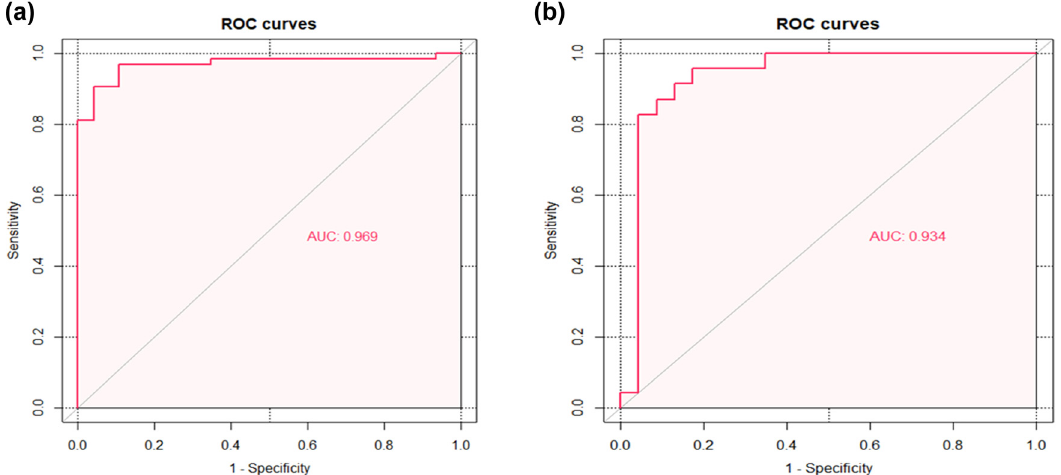
Figure 3: ROC curve to evaluate the discriminative performance of the nomogram in the training and validation cohorts. ( a ) Training cohort. ( b ) Validation cohort. ROC, receiver operating characteristic.